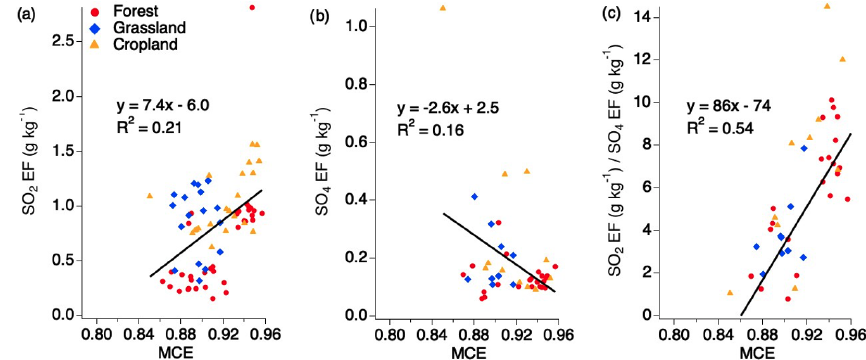
Figure 3. Scatter plots of EFs for SO 2 (a) , sulfate (b) , and the ratio of SO 2 to sulfate (c) (within 1h downwind of each fire source) vs. MCE based on combined fuel types.